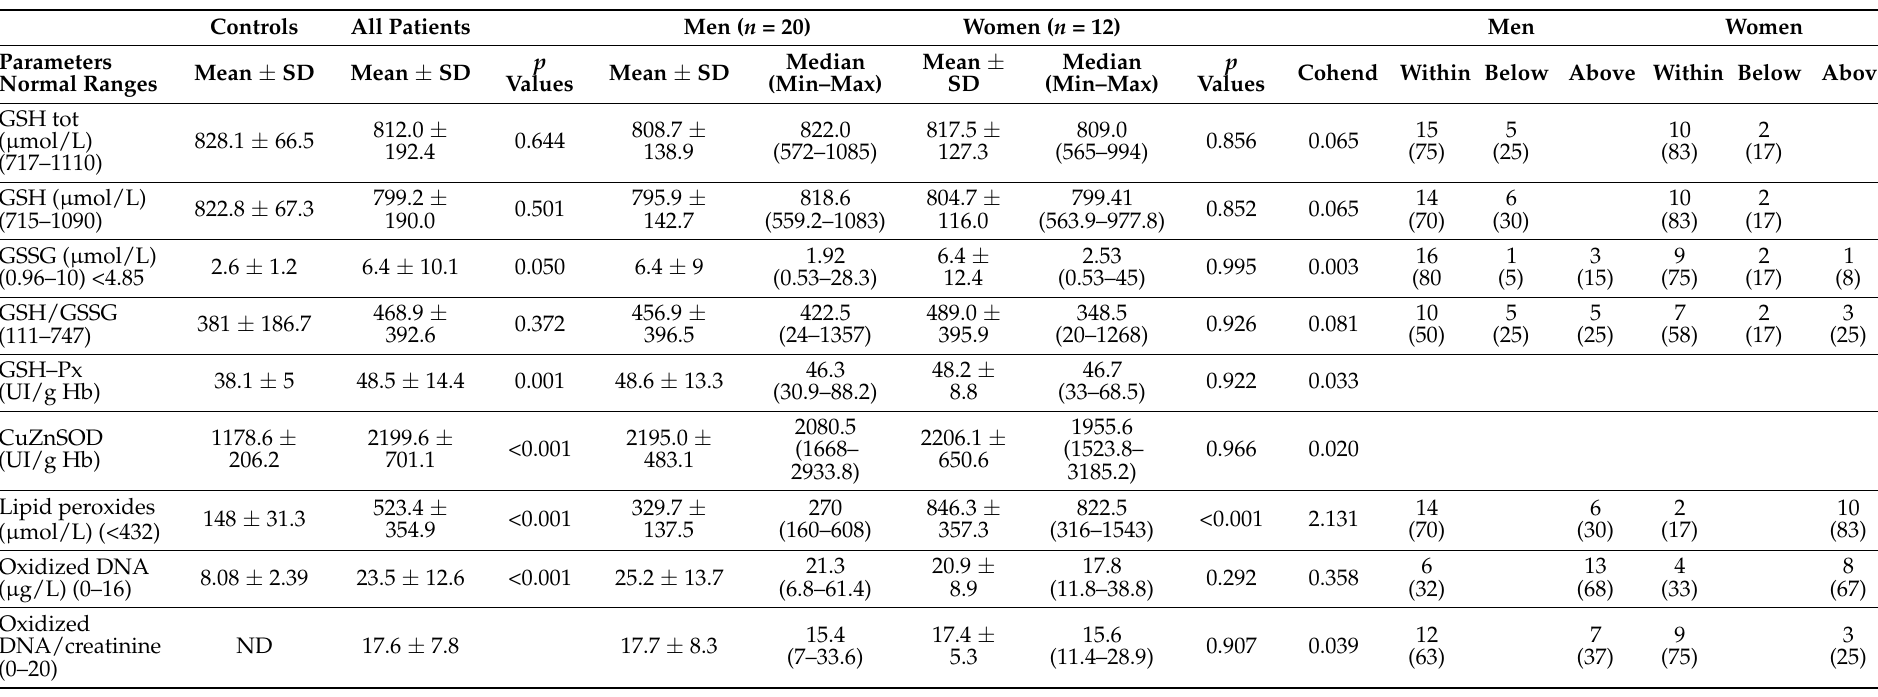
Table 12. Plasma and urinary levels of antioxidants and oxidative stress markers and their adequacy in controls and in 32 patients with FSHD.